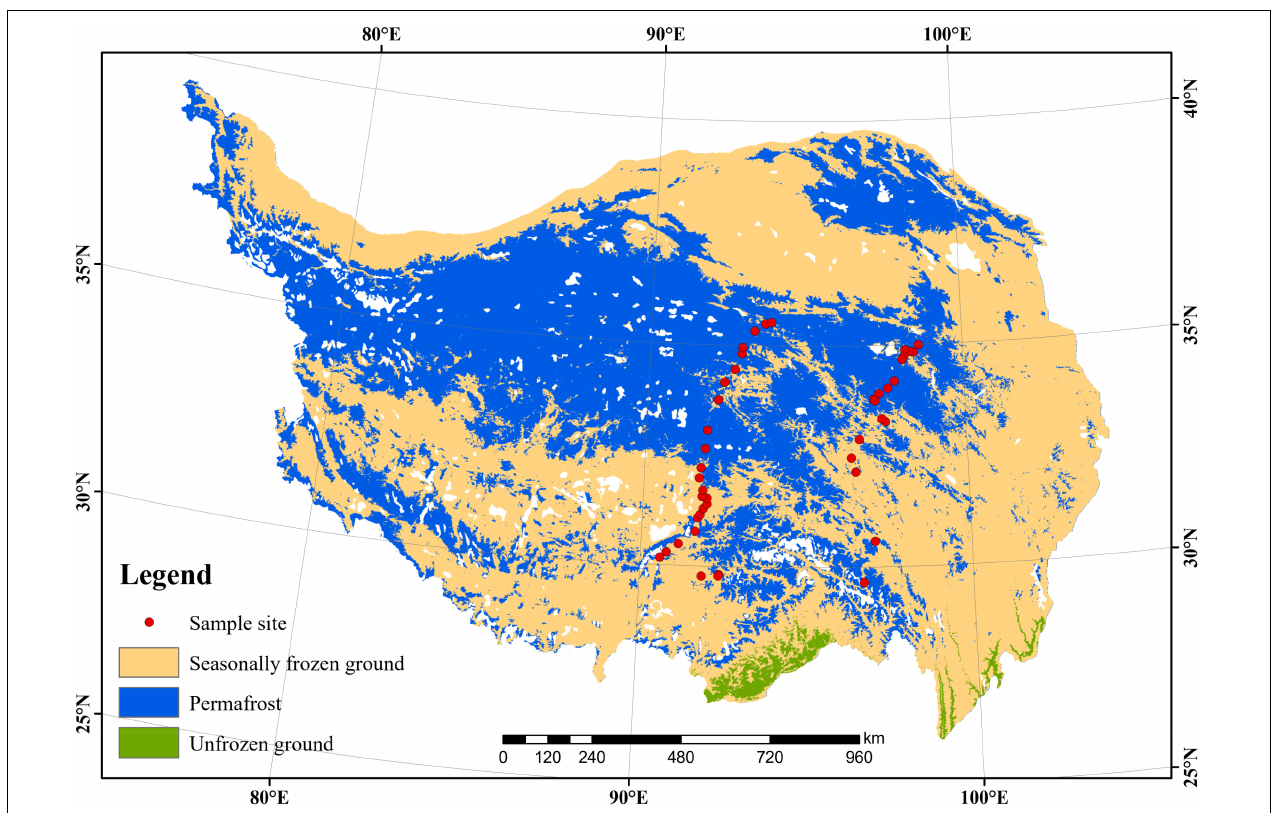
FIGURE 1 | Map of the 44 study thermokarst lakes across the Qinghai-Tibet Plateau. The distribution of the permafrost was cited from Zou et al. (2017).